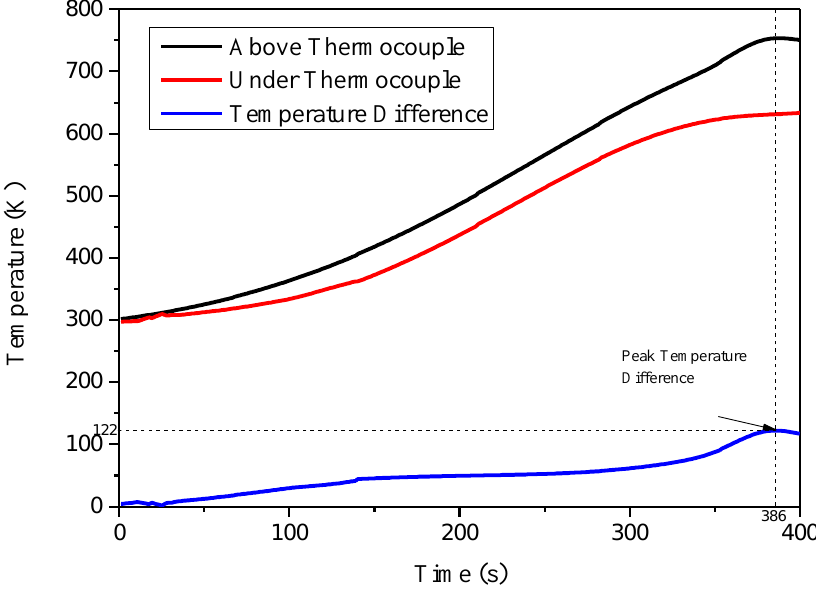
Figure 6. Temperature-time curves for two thermocouples at 20 kW m −2 .